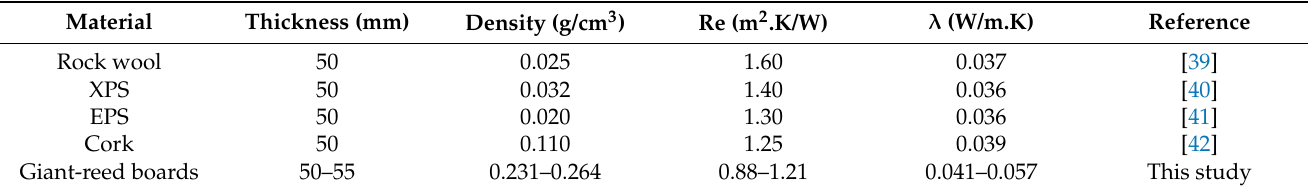
Table 10. Comparison between the thermal characteristics of the giant-reed boards and the ones of conventional thermal insulation